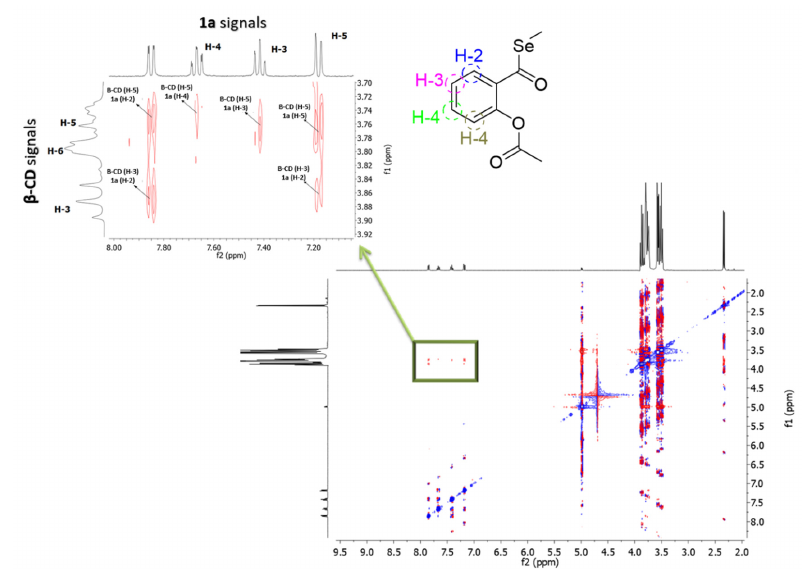
Figure 3. 2D-ROESY-NMR spectrum of 1a : β -CDs complex (1:1 molar ratio). Int. J. Mol. Sci. 2020 , 21 , x FOR PEER REVIEW